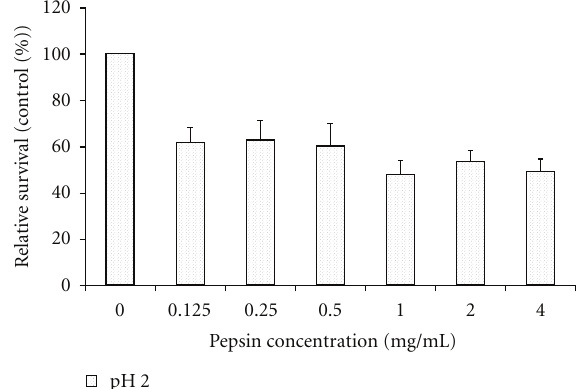
Figure 3: E ff ects of pepsin on cell survival, as measured by methylene blue absorption, and expressed as a % of absorbance of treatment with the corresponding pH without pepsin (control). Pepsin induced a significant decrease in cell survival independent of pH ( F = 6 . 5; P < 0 . 01). Data are expressed as means (histograms) and SEM (bars) for 3 replicates. See supplement Figure 1 for the e ff ect of pepsin on cell survival of all the pH levels used in the statistical analysis.